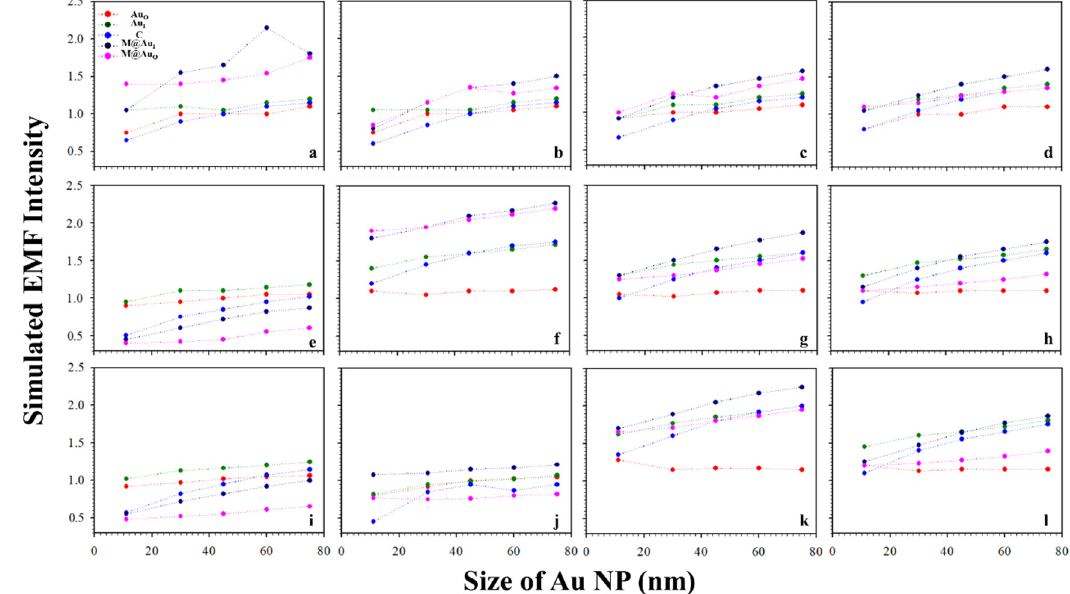
Figure 4. Plots of the simulated EMF intensity for the dimer of “Ab1/Au–NSE–Ab2/M@Au” vs. Au NP size at different locations of Au O , Au I , C, M@Au I , and M@Au O . ( a – d ) 6 nm Fe 3 O 4 core–Au shell thickness of 1 ( a ), 3 ( b ), 5 ( c ), and 10 nm ( d ); ( e – h ) 20 nm Fe 3 O 4 core–Au shell thickness of 1 ( e ), 3 ( f ), 5 ( g ), and 10 nm ( h ); ( i – l ) 30 nm Fe 3 O 4 core–Au shell thickness of 1 ( i ), 3 ( j ), 5 ( k ), and 10 nm ( l ).